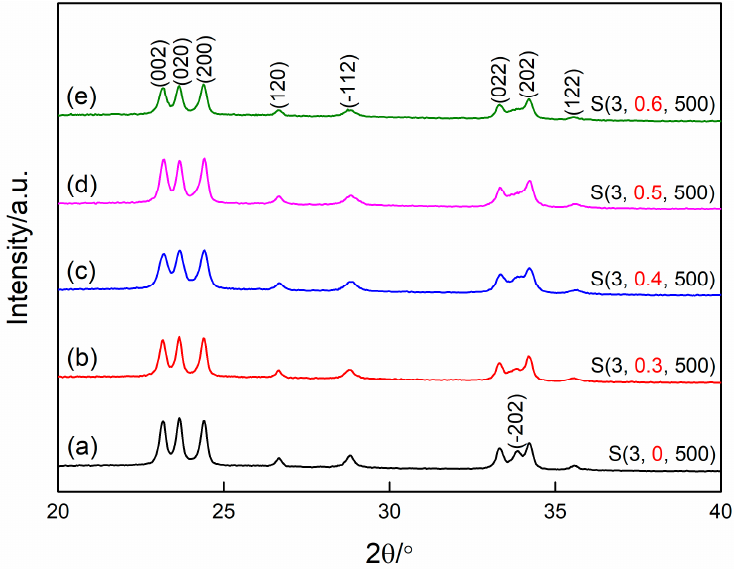
Figure 5. X-ray diffraction patterns of WO 3 films prepared at different PEG contents ( a ) without PEG, 181 ( b ) 0.3 g, ( c ) 0.4 g, ( d ) 0.5 g, ( e ) 0.6 g. 182 ( b ) 0.3 g, ( c ) 0.4 g, ( d ) 0.5 g, ( e ) 0.6